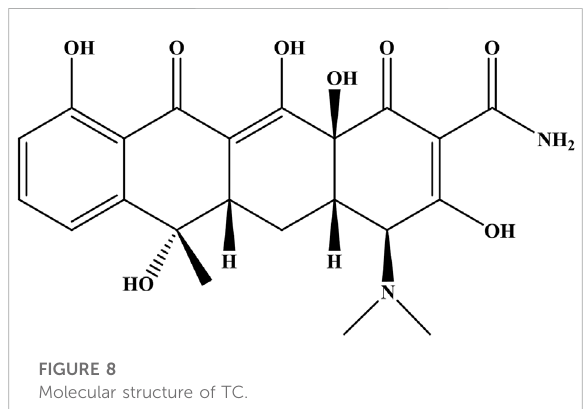
FIGURE 8 Molecular structure of